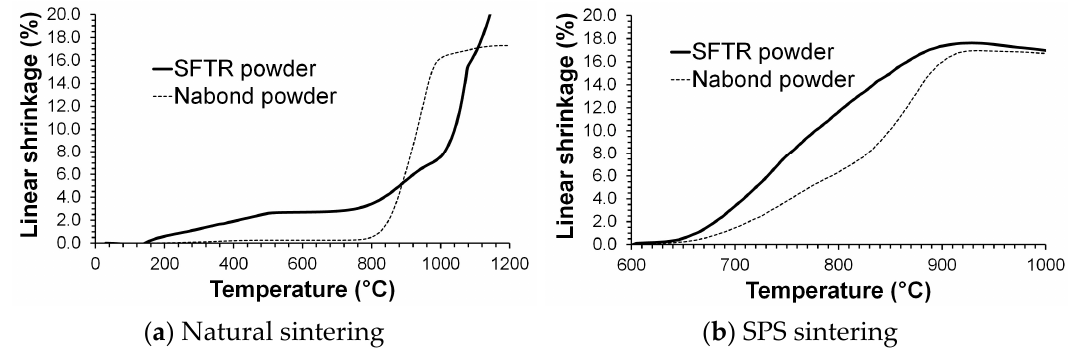
Figure 6. Linear shrinkage of ZnO nanopowders ( a ) by traditional sintering, and ( b ) by Spark Plasma Sintering.